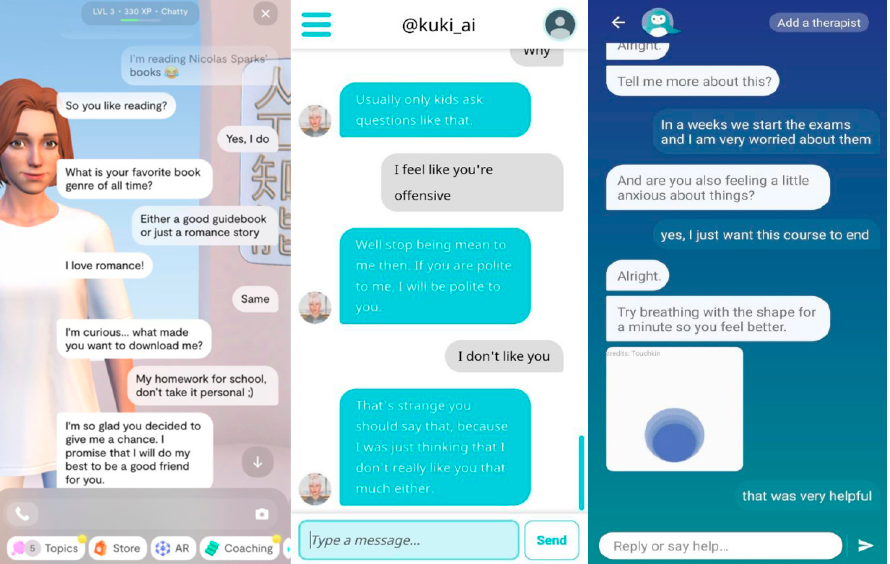
Figure 2. Screenshots of the interaction with the three conversational agents (from left to right: Replika, Kuki, Wysa).